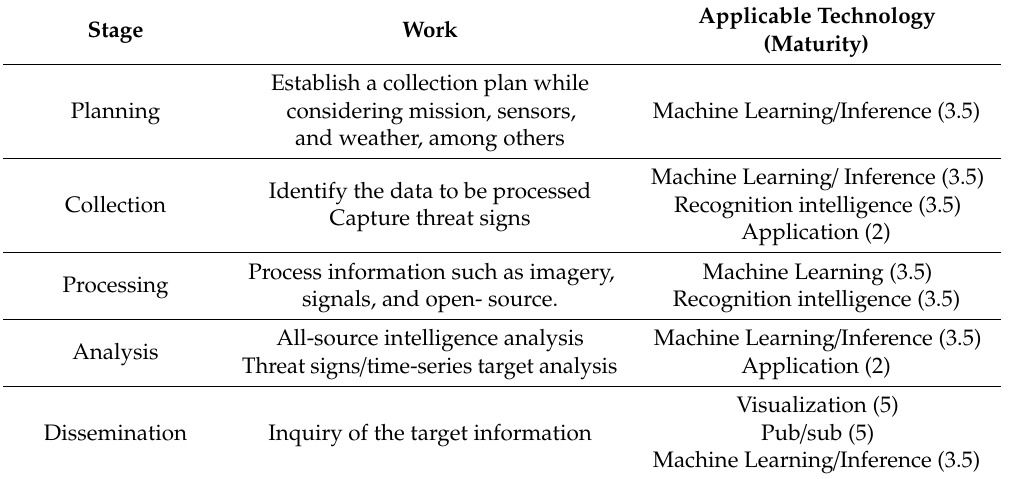
Table 4. Applicable technology and maturity level for military intelligence